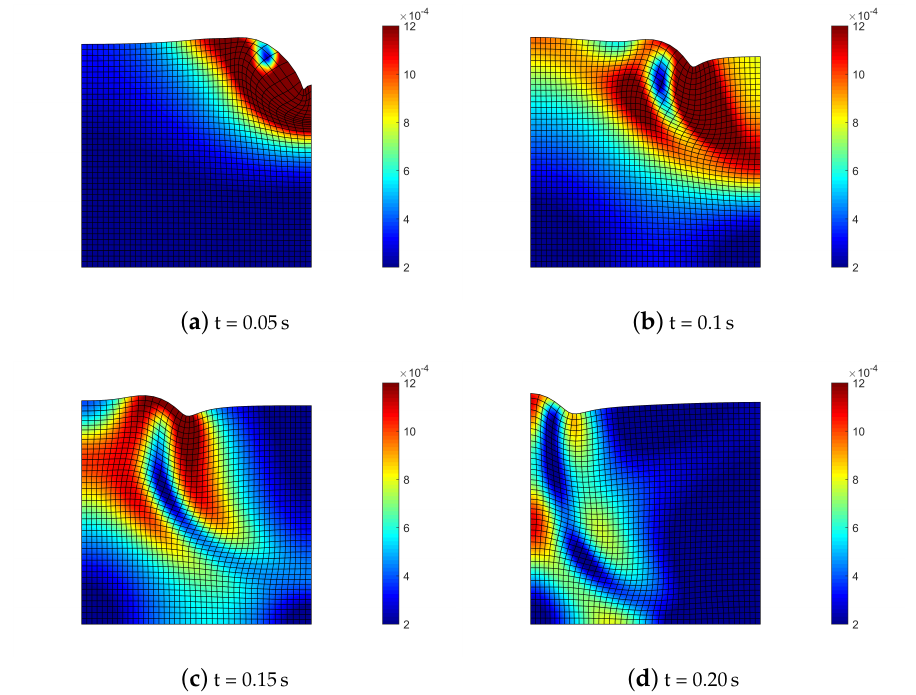
Figure 6. Deformed mesh (amplified by scale factor 500) and contours of norm of soil displacements = u S (cid:107) (cid:107)